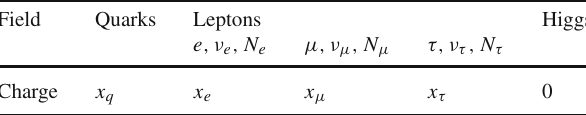
Table 1 U(1) Y (cid:4) charges of SM fermions and right-handed